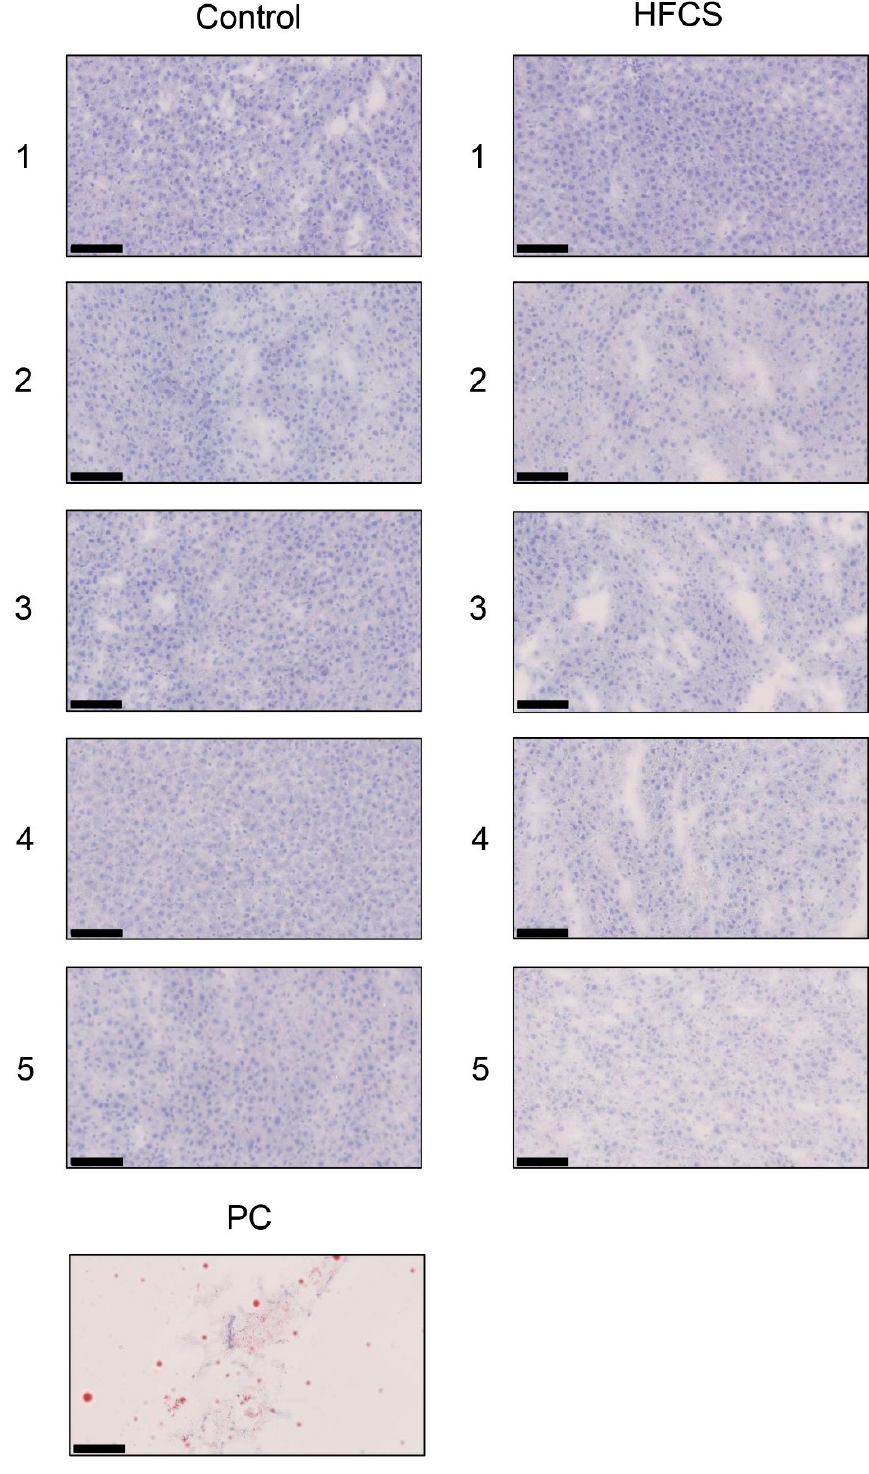
Figure 2. Histological analysis of the liver with Oil Red O staining. Control; control group, HFCS; HFCS group. The numbers 1–5 indicate each rat in the control group ( n = 5) or HFCS group ( n = 5). PC; Positive control. Adipose tissue of rat. Fat-positive areas stained red in cells. The scale bar represents 100 μ m.